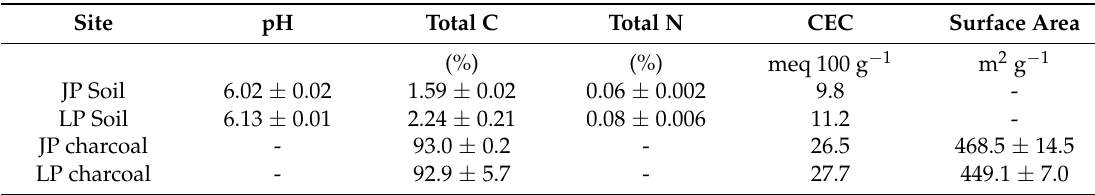
Table 1. Physical and chemical properties of Jeffrey pine (JP) and lodgepole pine (LP) soils and charcoal used in this study. The pH, total C, and total N measurements were done in triplicate, surface area was measured in duplicate, and no replicates were used for cation exchange capacity (CEC)